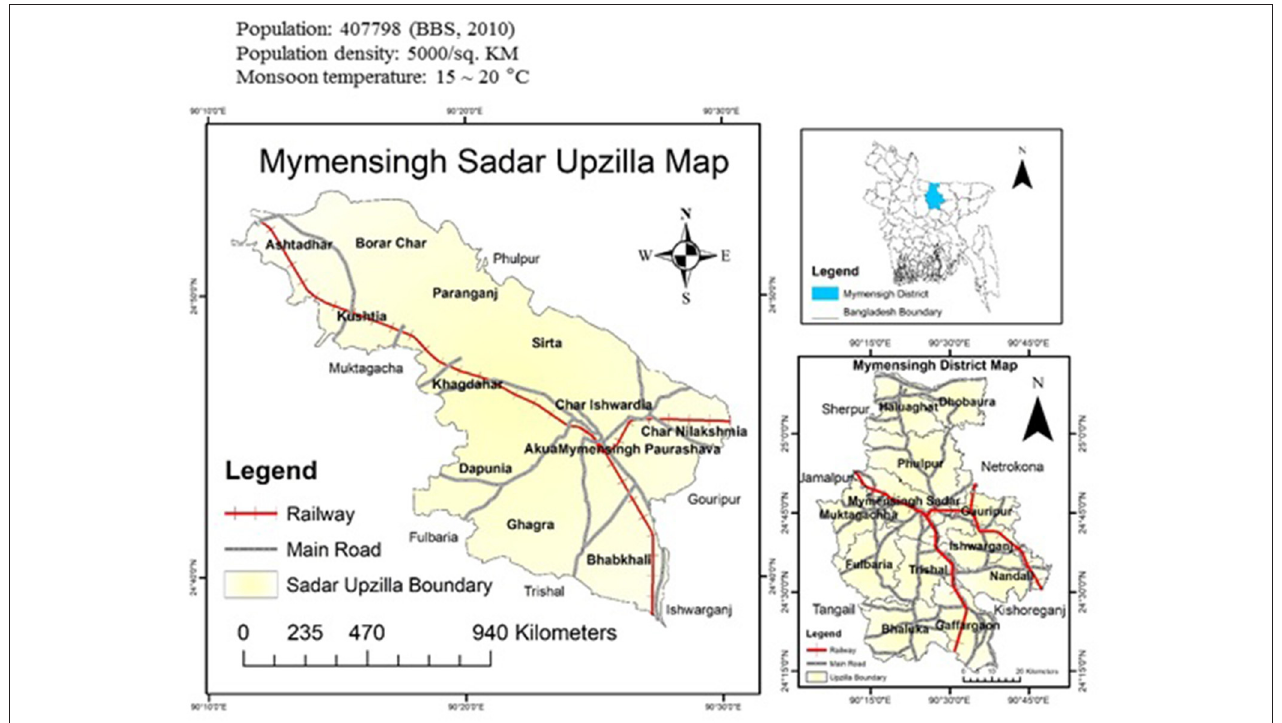
FIGURE 2 | Mymensingh District and Sadar Upzilla